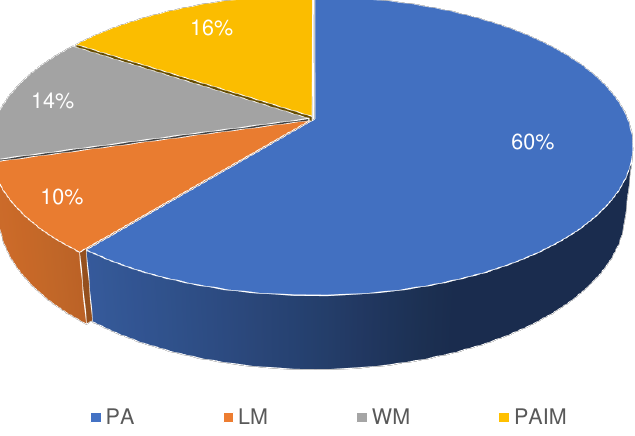
Figure 4. Thematic distribution of reviewed papers ( N = 53) depicting important uses of IoT-WSN in smallholder agriculture (PA:Precision Agriculture, LM: Livestock Management, WM: Weather Monitoring, PAIM: Pest and Animal Infestation Monitoring); classes may be mutually